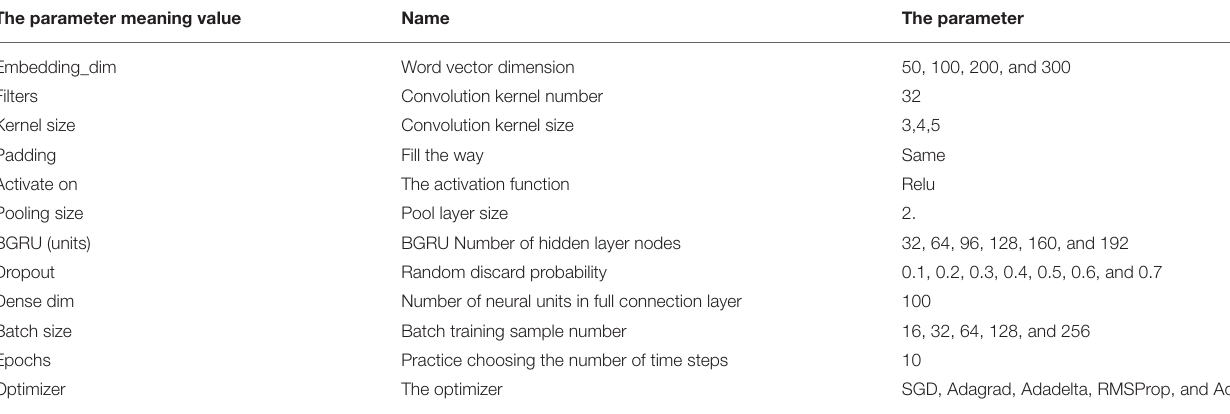
TABLE 2 | Parameter setting of the attention mechanism model in the parallel hybrid network. The parameter meaning value